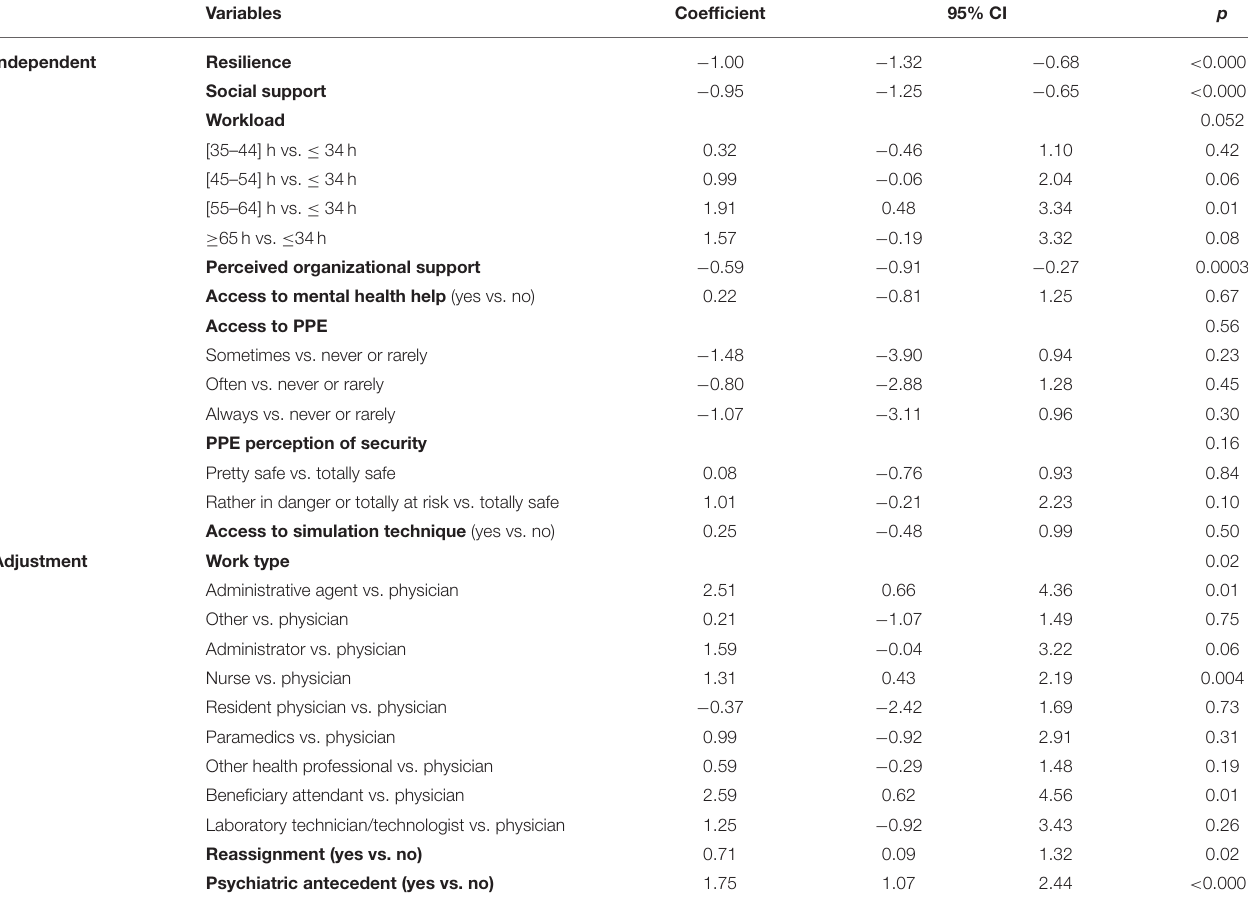
TABLE 6 | Adjusted coefficient, 95% confidence interval and p -values from multivariable linear regression analysis for depression scores among participants ( n = 419). Variables Coefficient